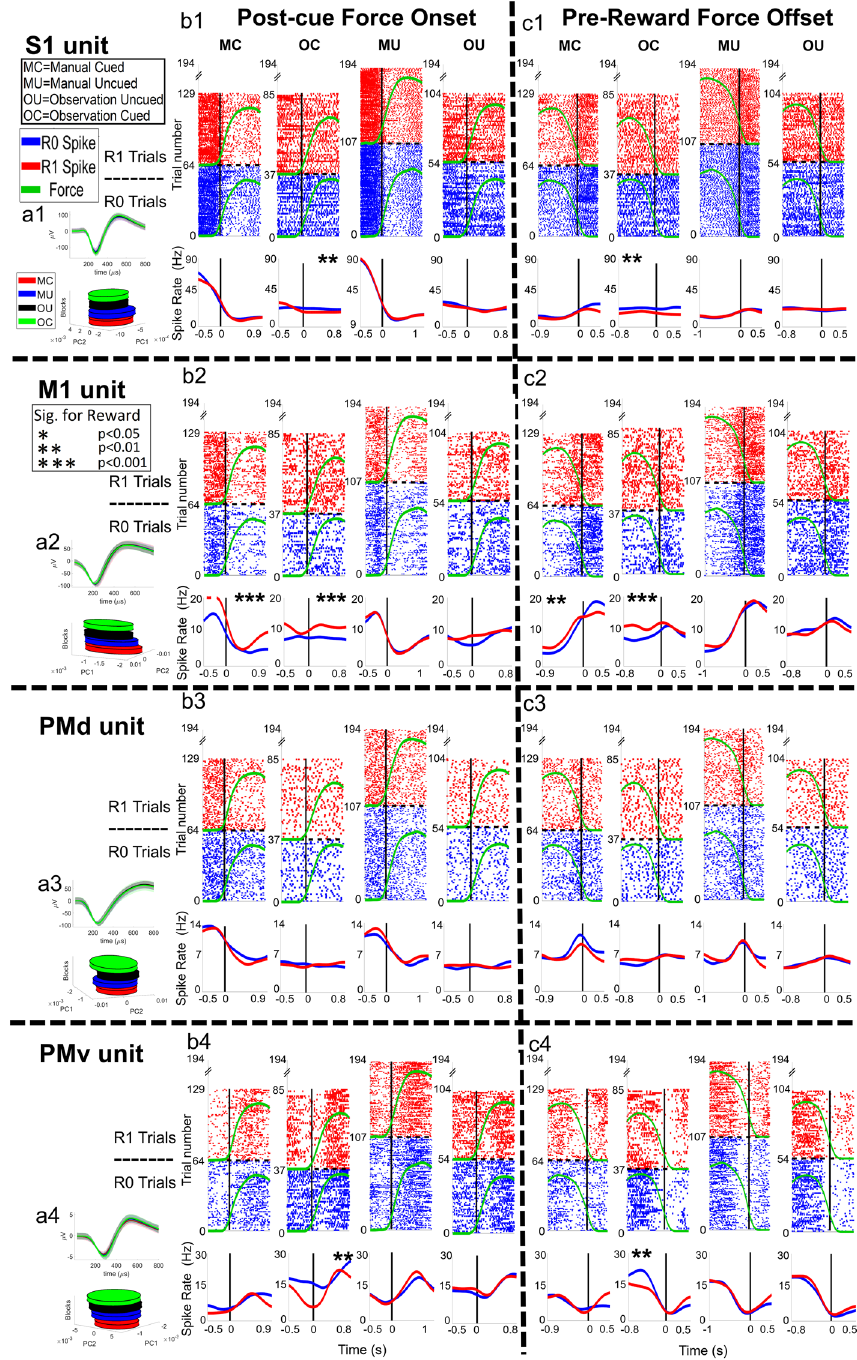
Figure 3. Raster plots of example units from NHP S during the manual and observational blocks. The plot numbers, 1–4, indicate the brain regions (1–4 for cS1, rM1, PMd, and PMv, respectively). The letters, a-c, before the numbers 1–4, are associated with (a) single unit waveform for the example unit, (b) force onset plots, and (c) for force offset plots. For (b) and (c), there are four plots for the manual cued task (MC), observational cued task (OC), manual uncued task (MU), and observational uncued task (OU) sequentially. The post-force onset and pre-force offset time are set as 60% of the mean force length of all trials for that task. On each subplot (b, c), the x-axis represents time in seconds. For raster plots, the y-axis represents the trial number. For spike rate plots (bottom of subplots) y-axis is the spike rate in ‘Hz’. The dashed horizontal black line on each plot divides the R1 trials from R0 trials. Below the raster plots, solid red and blue lines indicate the mean spike rate (Hz) for R1 and R0, respectively. An asterisk (*) indicates post force onset or pre-force offset spike activity is significantly (t-test, p < 0.05, p < 0.01 and p < 0.001 denoted by *, ** and *** respectively) different between R0 and R1 trials. All figures shown are significant for force modulation; see methods. See Fig. S21 for a zoomed-in y-axis version for observational